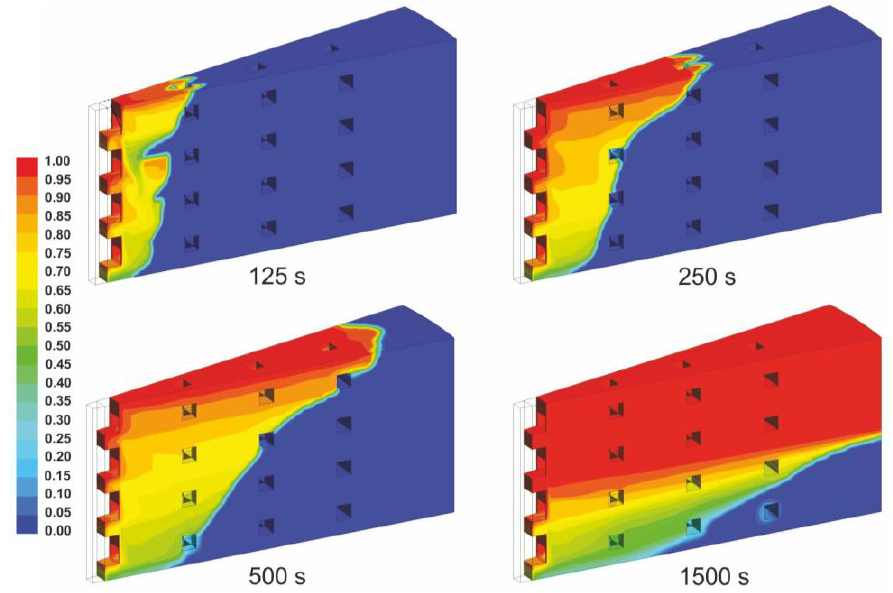
Figure 5. Contours of the liquid fraction of the PCM during the melting process at different time steps. A vector plot of the velocity including the liquid fraction of the PCM is represented in Figure 6.